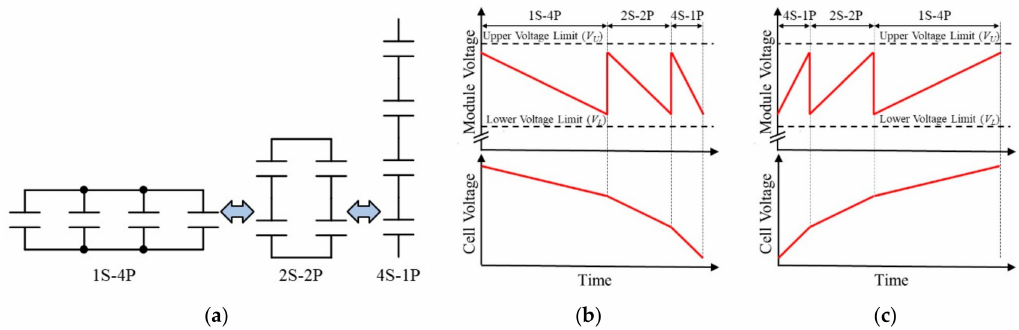
Figure 3. ( a ) Typical reconfiguration sequence of balance-shift circuit for four-cell module, ( b ) its discharging, and ( c ) charging